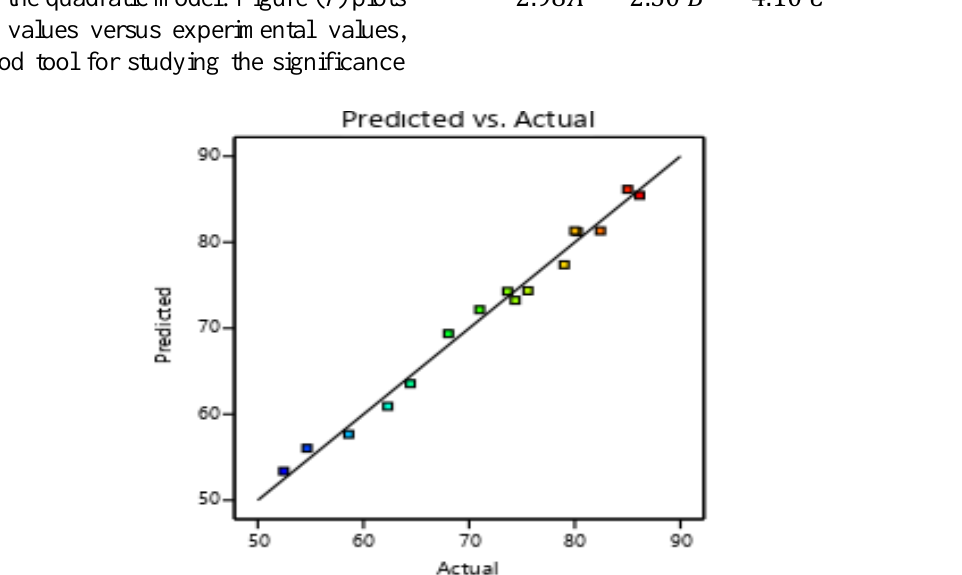
Fig. 7. The predicted values versus experimental